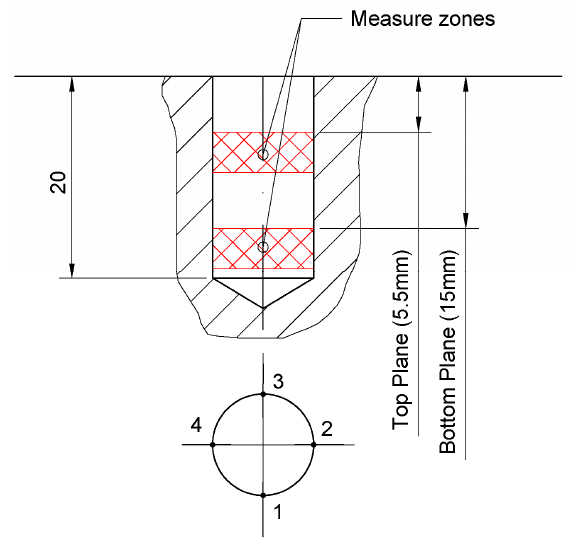
Figure 3. Cylindrical sections inside the holes where the measurements of roughness were taken for the evaluation of average roughness ( Ra ) (striped in red) and, in each one of them, the specific zones to take the measurements are defined by the four points separated to 90° and marked as 1, 2, 3, and 4.